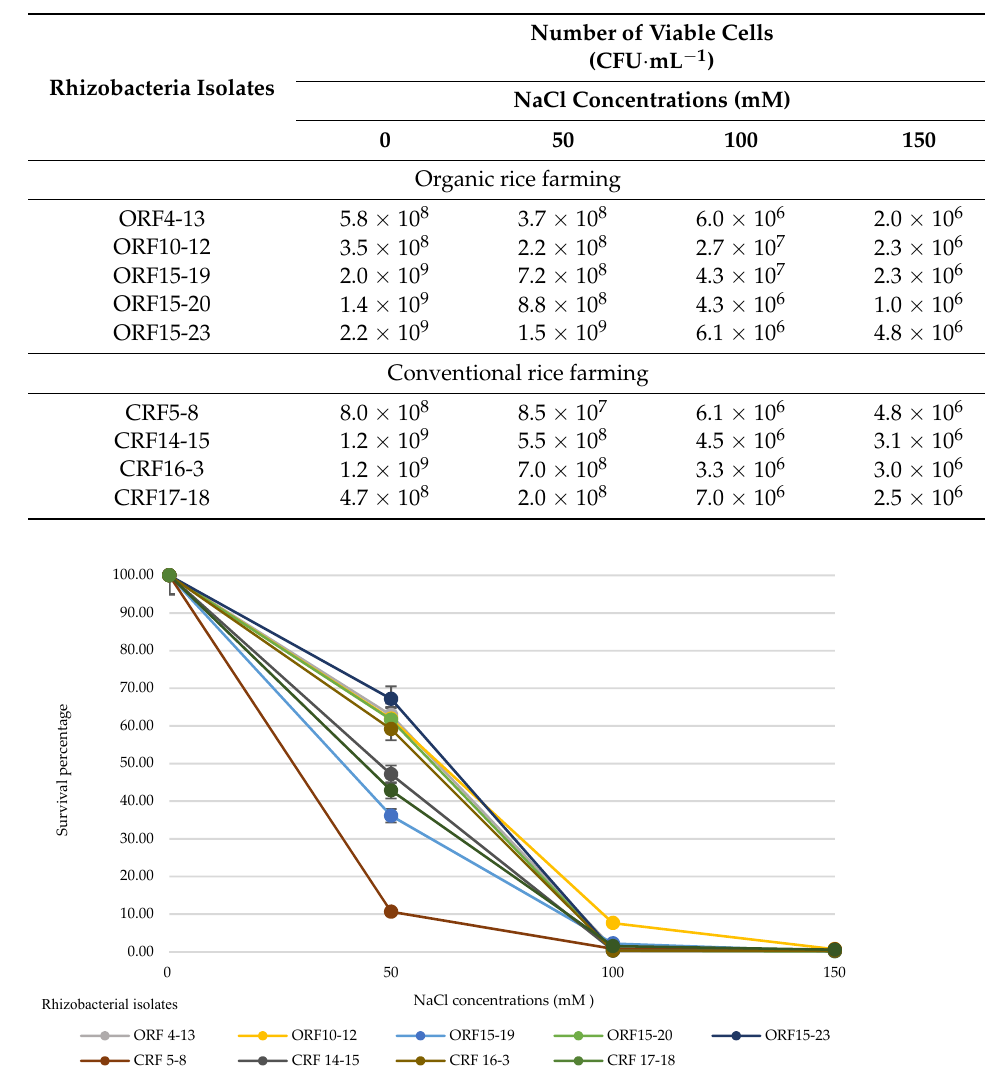
Figure 3. Survival of rhizobacterial isolates under different concentrations of NaCl in Hoagland’s solutions after 30 days of inoculation. The error bars represent the standard deviation of measurements for three replications.